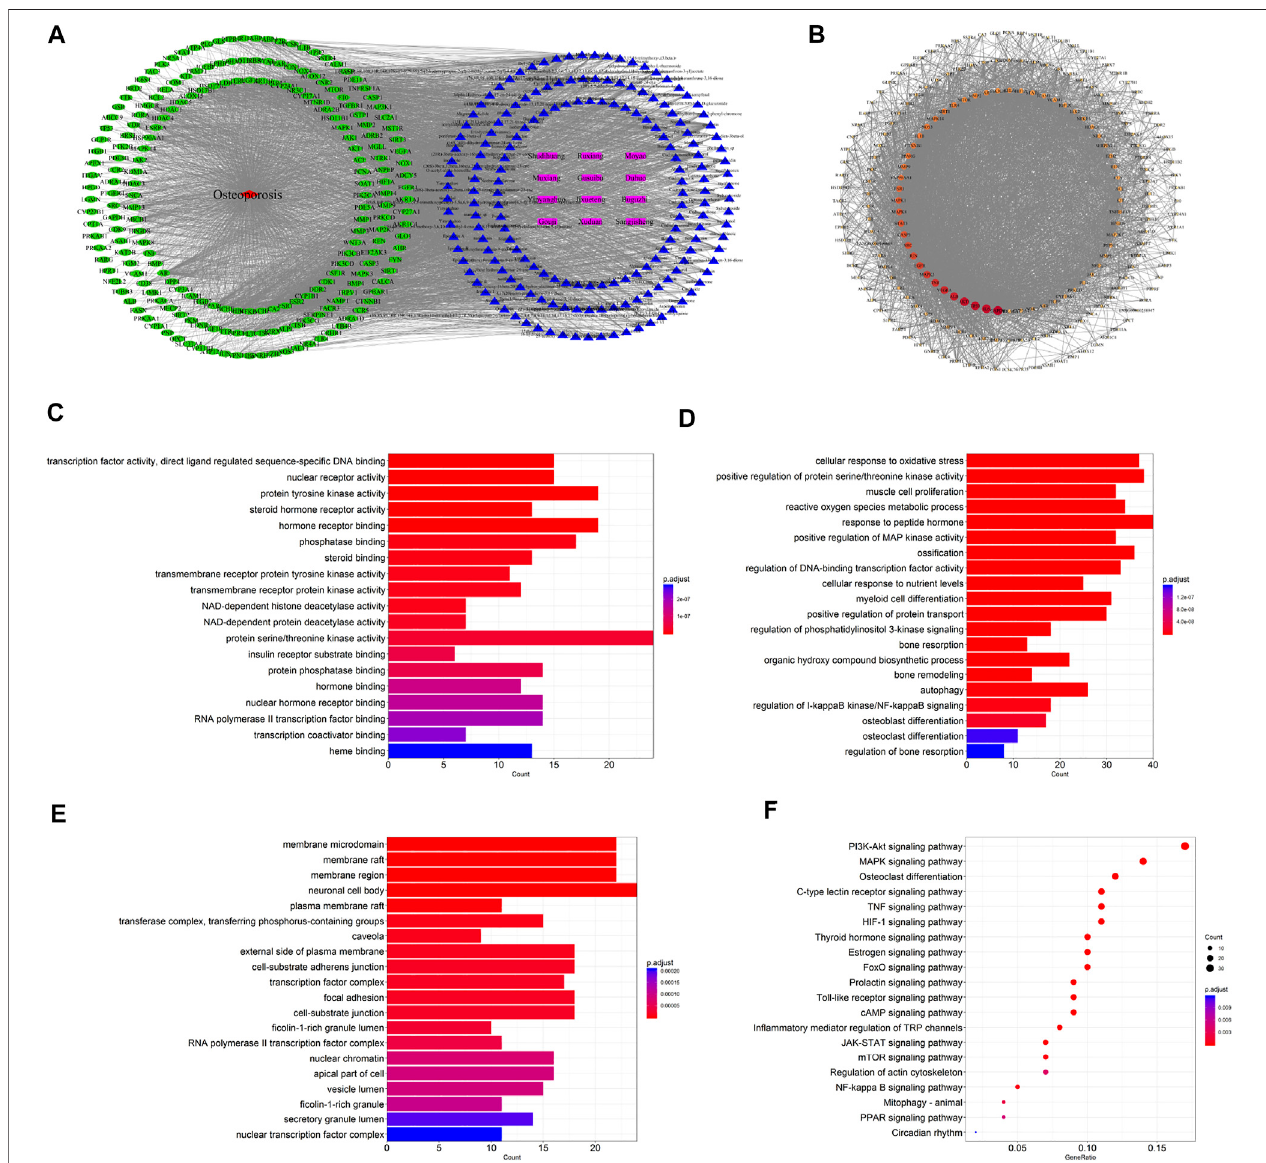
FIGURE 2 | Network pharmacology-based analysis for target genes and underlying pathways of ZG in osteoporosis treatment. (A) The drug-bioactive ingredient- target-diseasenetworkofZGactingonosteoporosisbasedontheinteraction ofdrug(ZG),bioactive ingredients, targetgenes,anddisease.Purple nodesrepresent the drug; blue nodes represent the bioactive ingredients; green nodes represent the osteoporosis-related targets; red node represents the disease. (B) The proteinprotein interaction(PPI)networkofoverlappinggenesbetweenZGandosteoporosiswasobtainedfromtheSTRINGdatabaseandconstructedbyCytoscape.Thenodes represent the overlapping genes. The edges indicate the interaction among the nodes. The size and colors of the nodes from red to orange to blue were illustrated in descending order of degree values. (C – E) The gene ontology (GO) enrichment analysis for overlapping genes between ZG and osteoporosis associated with molecular functions (C) , biological processes (D), and cellular components (E) . The x-axis showing the signi fi cant enrichment in the genes counts. The y-axis showing the categories in the GO of the target genes. (F) The Kyoto Encyclopedia of Genes and Genomes (KEGG) pathway enrichment analysis of overlapping genes between ZG and